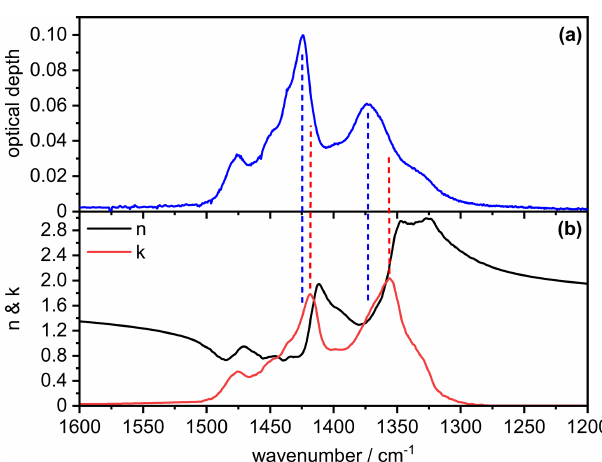
Figure B1. Comparison between the measured infrared extinction spectrum of crystalline AN particles (a) and the retrieved optical constants (b) in the 1200–1600cm − 1 wavenumber range. The re- trieval was performed with the parameters n( ˜ ν x ) = 1 . 56, χ = 1 . 1, and ϕ = 1. Vertical dashed lines indicate peak positions in the par- ticle extinction spectrum (blue) and the k( ˜ ν) spectrum